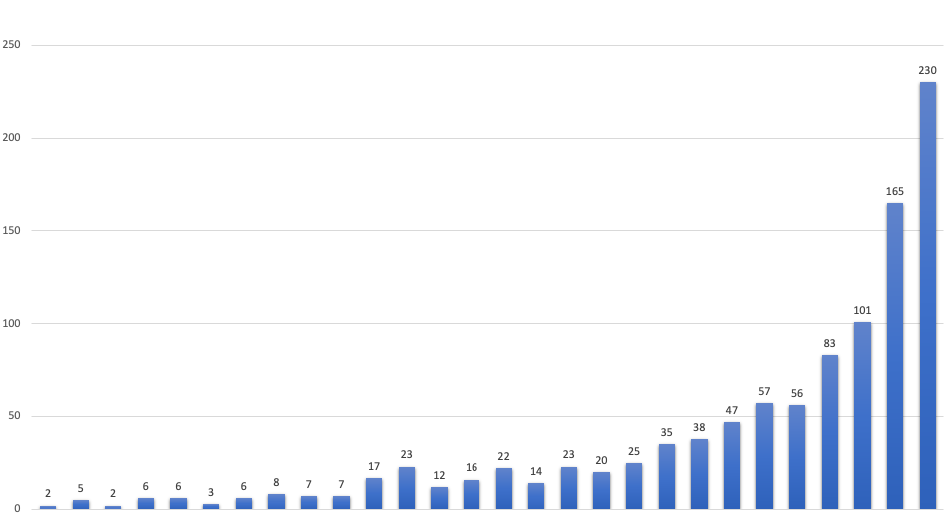
Figure 5. Trend of Publications on Augmented Reality in Surgery over the